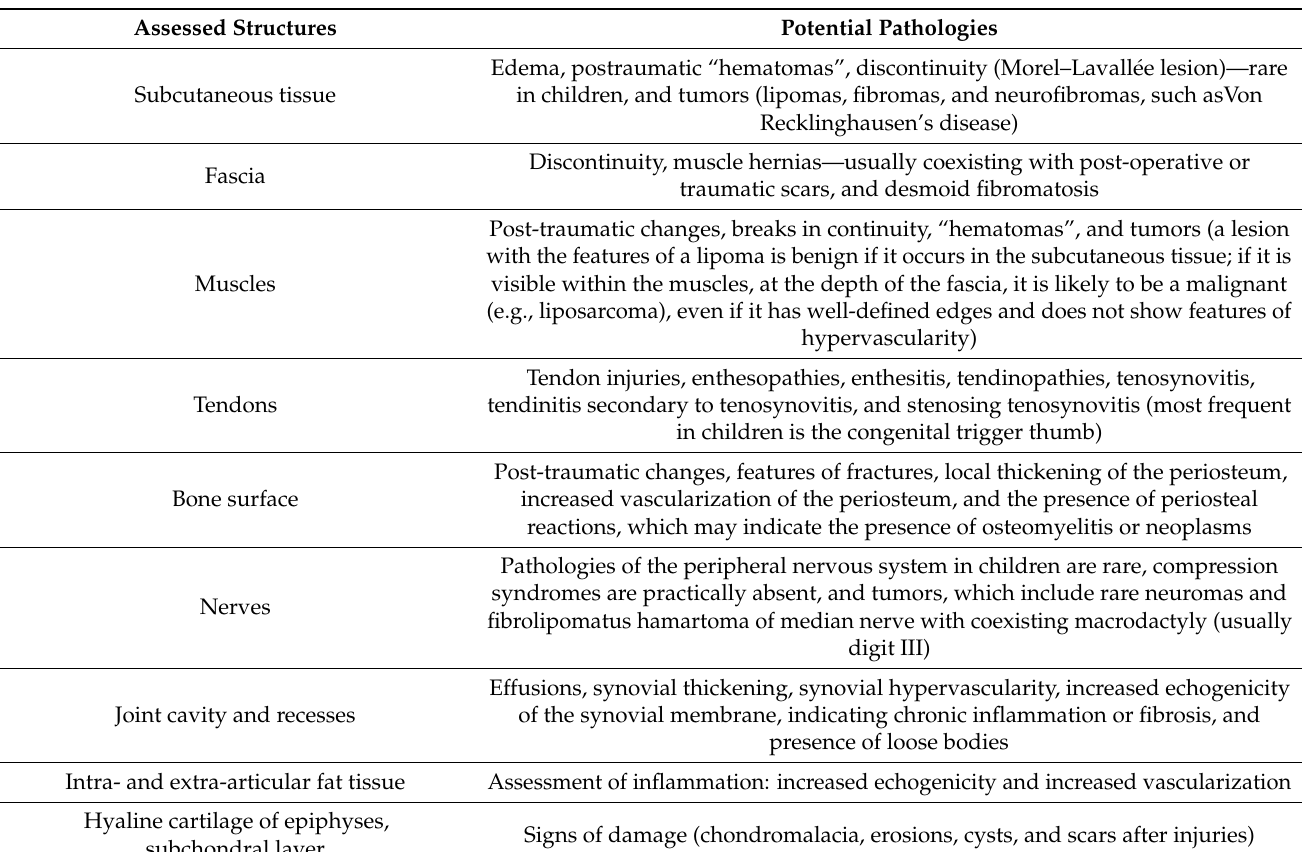
Table 2. US assessment of the tissues within the musculoskeletal system and the most common pathologies found within these tissues in children.